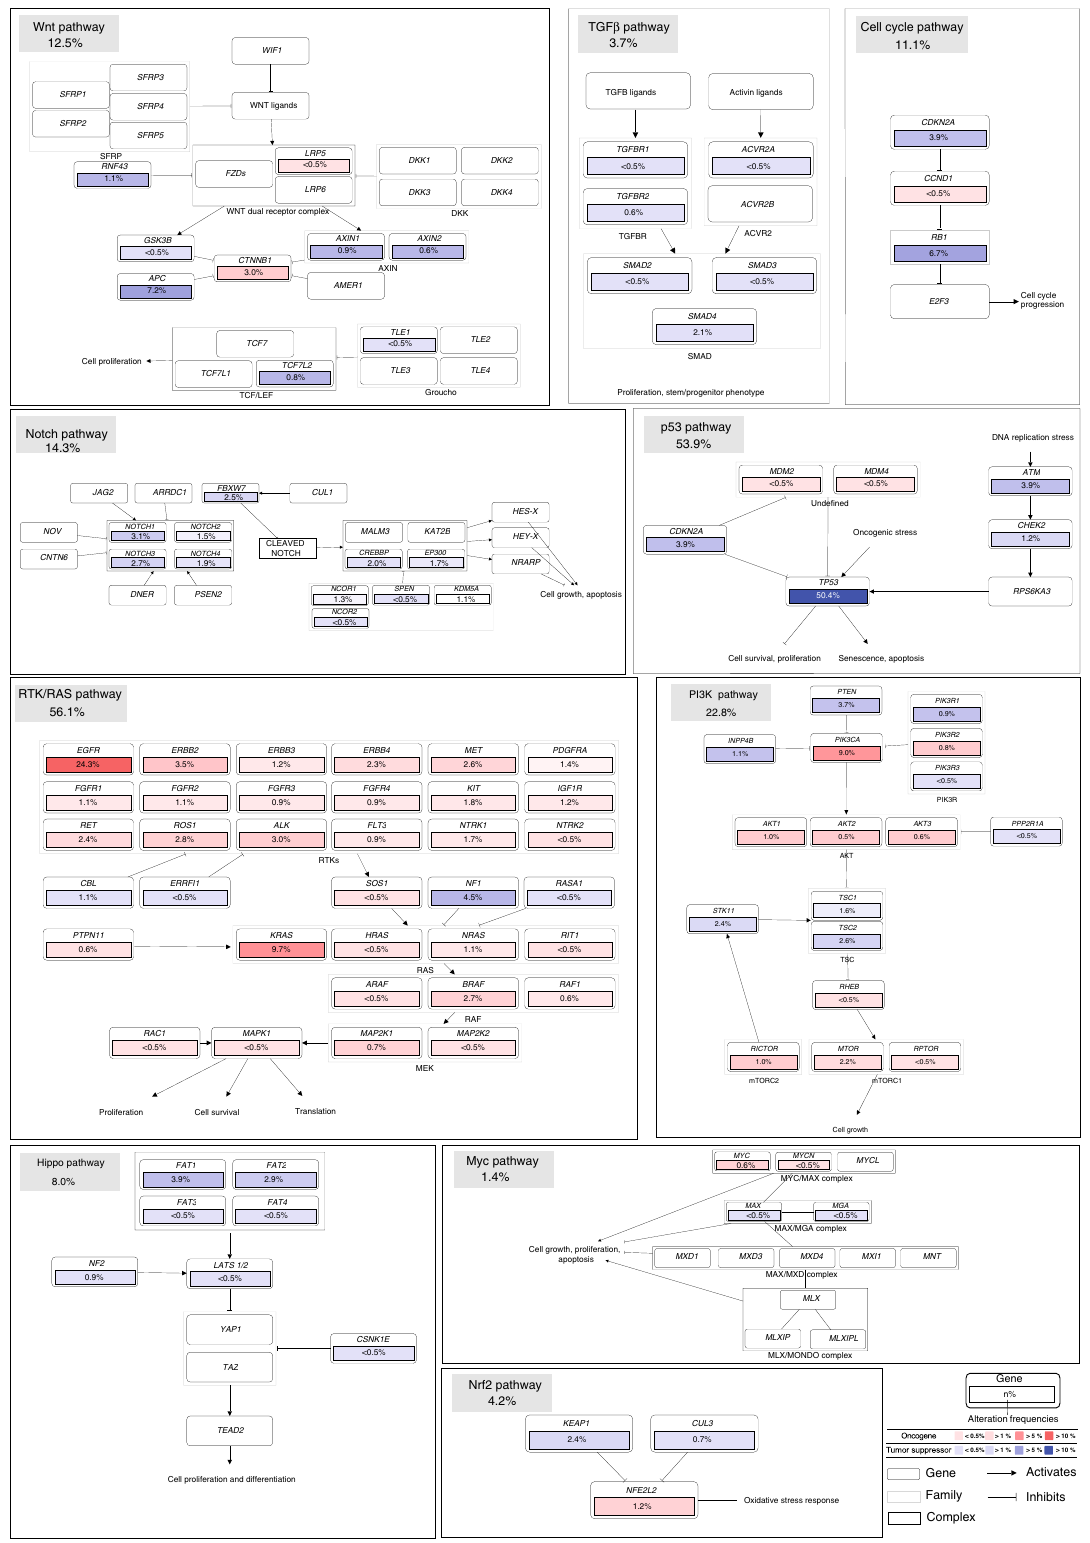
Fig. 4 Pathway members and interactions in the ten selected pathways. Oncogenes and tumor-suppressor genes are illustrated with red and blue, respectively. Color intensity indicates the frequency of alteration within the entire dataset. Blank boxes represent genes not covered in our sequencing